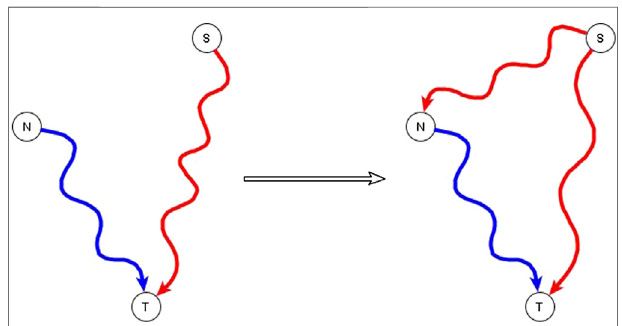
FIGURE 1 | Illustration of the co-pointing subgraph theorem for inferring logic implication between two regulators. The source node S is suf fi cient indirectly ( via a path or a subgraph) for the target node T and the non-source node N is necessary indirectly for the target node T. The two subgraphs from StoTandfromNtoTareco-pointingsubgraphs. Thisleadstoinference ofadirect orindirectcausallogic implication that thesignal node Sissuf fi cient for the non-source node